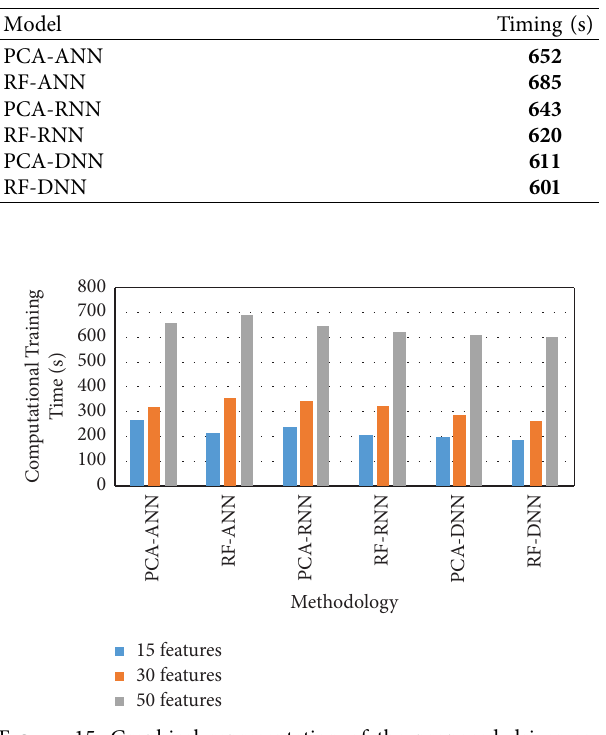
Figure 15: Graphical representation of the proposed driver as- sistance model for diferent number of features in terms of computational training